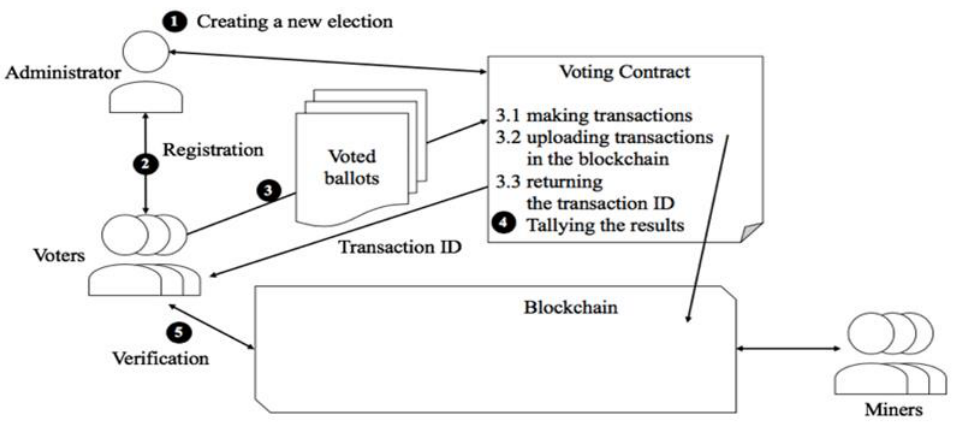
Figure 13. The overall procedure in e-voting using blockchains [17].